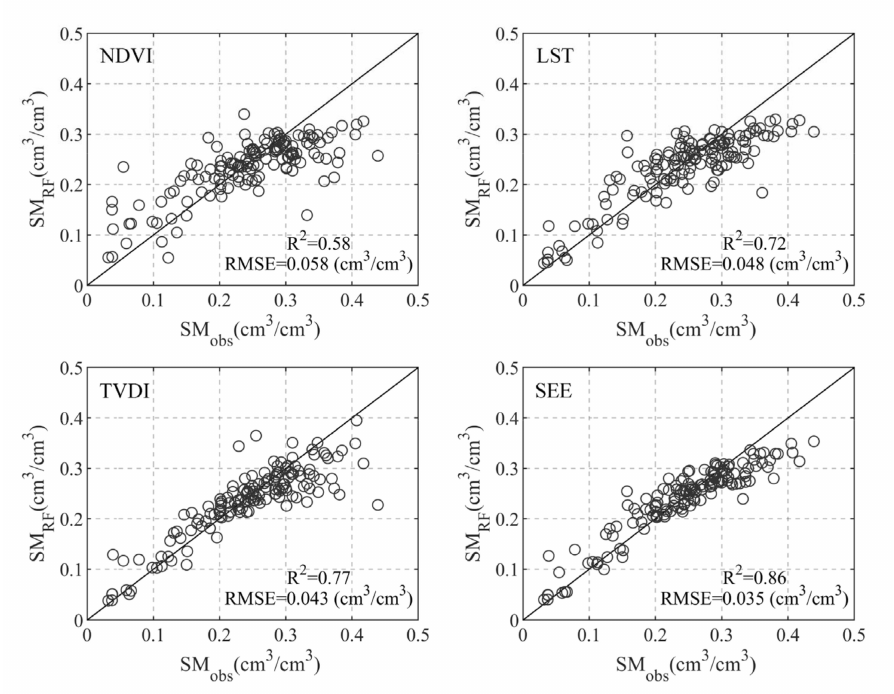
Figure 8. Scatter plots of the observed soil moisture and RF mapped soil moisture with single auxiliary